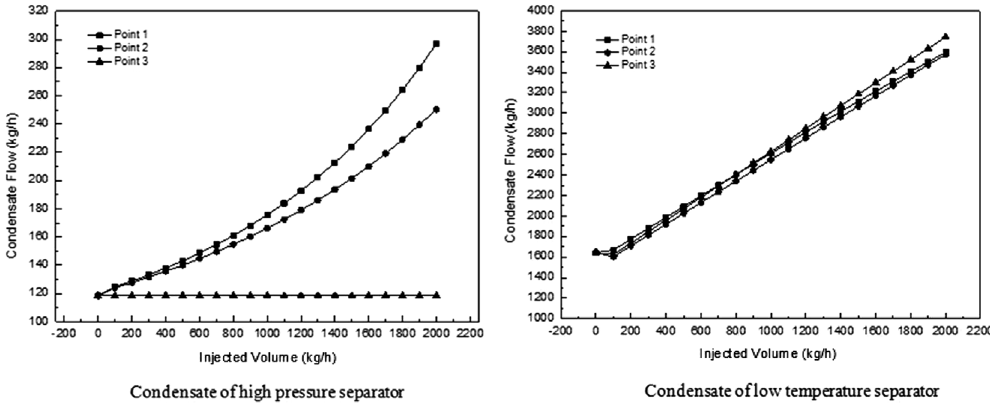
Fig. 13. The variation of condensate fl ow of high-pressure separator/low temperature separator with the injected volume.